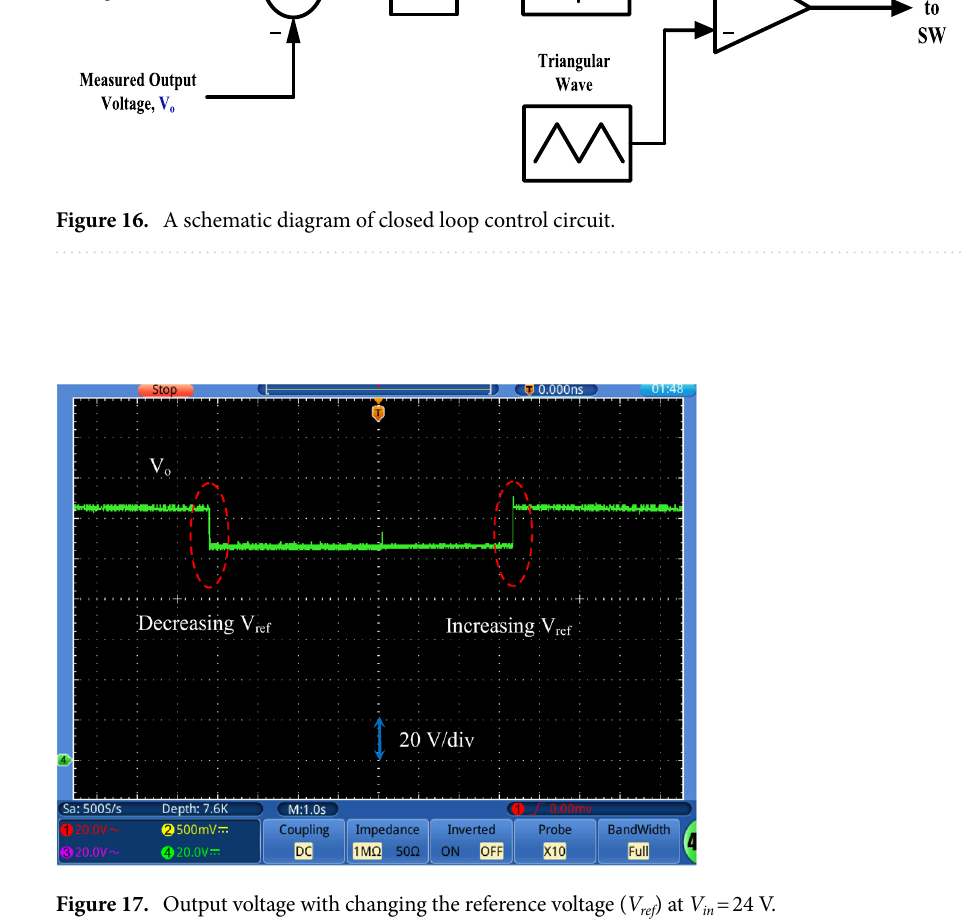
Figure 17. Output voltage with changing the reference voltage ( V ref ) at V in = 24 V.